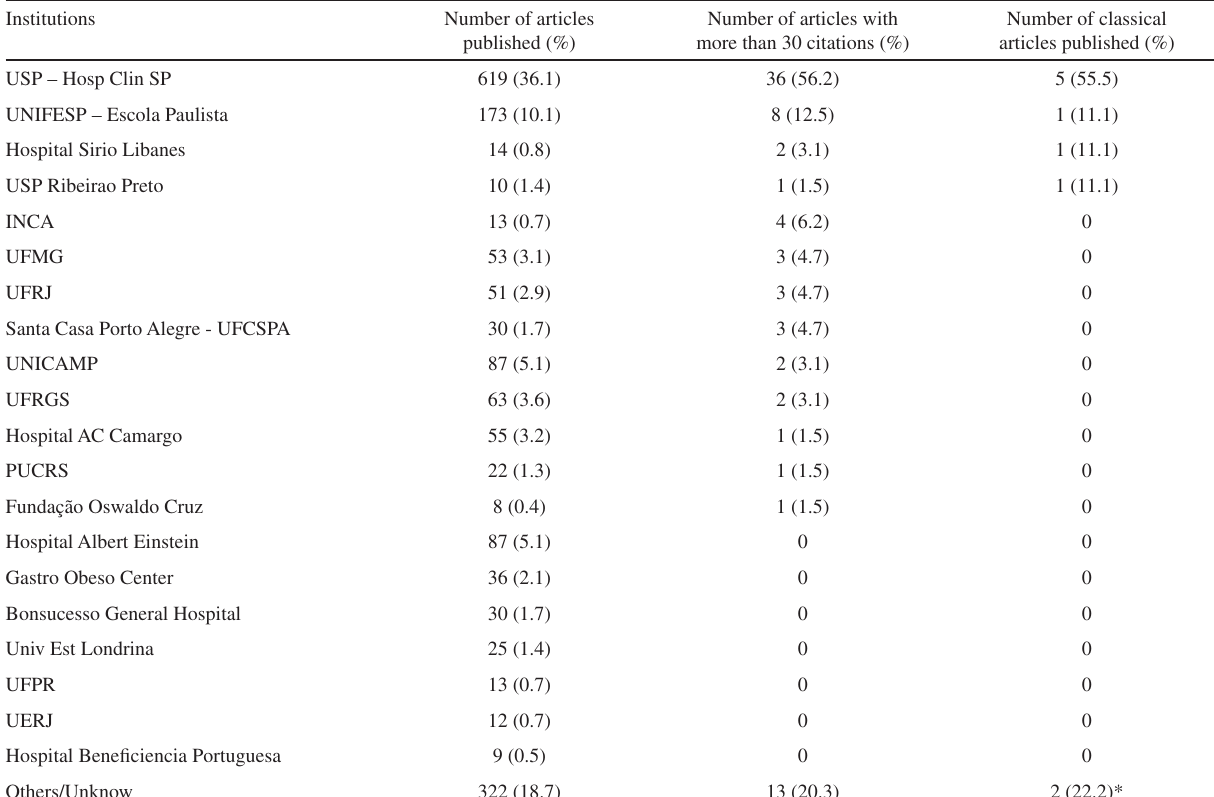
Table 6 - Brazilian most-cited articles in general surgery, sorted by the top contributing Institutions.